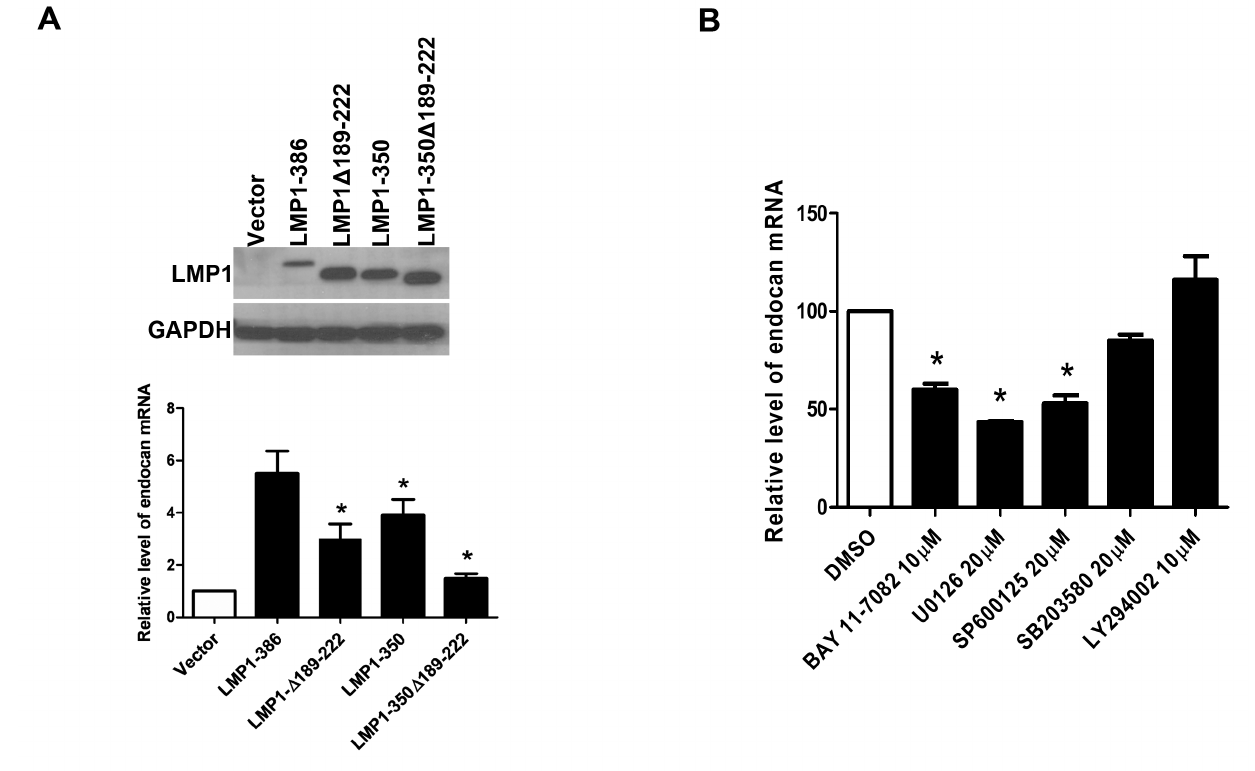
Figure 3. The signaling pathways involved in LMP1 induction of endocan. ( A ) Upregulation of endocan expression by LMP1 is mediated through the CTAR1 and CTAR2 domains of LMP1. 2 x 10 5 H1299 cells were transfected with 1 μg of pIRES-puro- LMP1-386, pIRES-puro-LMP1Δ189-222, pIRES-puro-LMP1-350, pIRES-puro-LMP1-350Δ189-222 or vector plasmid (pIRES-puro). 24 h later, the expression of the full-length and mutant LMP1 proteins were determined by Western blot analysis (upper panel) and the expression of endocan mRNA was determined by quantitative real-time RT-PCR. The level of endocan mRNA expressed in cells transfected with vector plasmid was set as 1 and the relative levels of endocan mRNA expressed in different transfected cells are shown in lower panel. Values represent means ± SD. * P < 0.05 versus pIRES-puro-LMP1-386-transfected cells. ( B ) Upregulation of endocan expression by LMP1 is mediated through the NF-κB, MEK-ERK and JNK signaling pathways. RHEK/Tet- LMP1 cells were pretreated for 1 h with DMSO (solvent for inhibitors) or various signaling pathway inhibitors as indicated. Cells were then incubated in media containing 1 μg/mL doxycycline for 36 h. Total RNA was extracted and the amount of endocan mRNA expressed in the presence of various inhibitors was quantitated by quantitative real-time RT-PCR. The level of endocan mRNA expressed in cells treated with DMSO was set as 100%. Values represent means ± SD. * P < 0.05 versus DMSO-treated cells. doi: (Figure 4A, panel b and c). Endocan is known to be expressed in tumor endothelium (27). To confirm that endocan is expressed in the NPC cells rather than the endothelial cells in the NPC specimens, the endocan-positive NPC tissue was stained with antibody against von Willebrand factor (vWF), a marker for endothelial cells. As shown in Figure S2, the NPC tissue was largely stained vWF-negative, indicating that the cells expressing endocan are NPC cells rather than endothelial cells. It has been reported that endothelial cells in the vicinity of the tumor can be induced to express endocan by tumor-derived factors (27). In consistence with this, we also noted that endocan was expressed in the vascular endothelial cells adjacent to tumors (Figure 4A, panel d and Figure S3). Overall, the positive immunostaining rate of endocan expression in